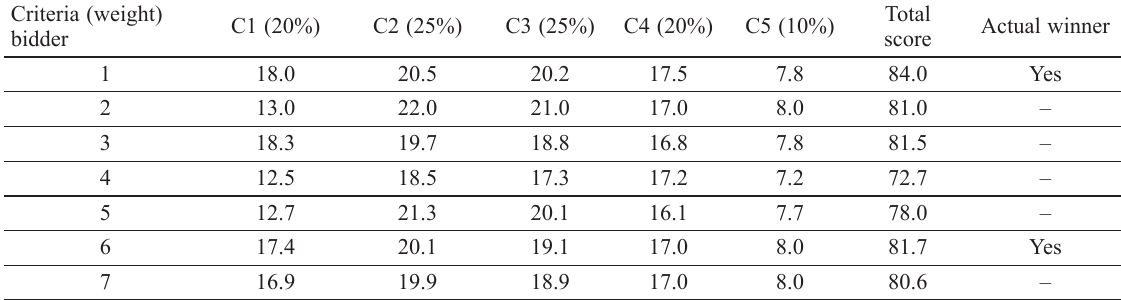
Table 3. Actual evaluation data of case project 2 Criteria (weight)